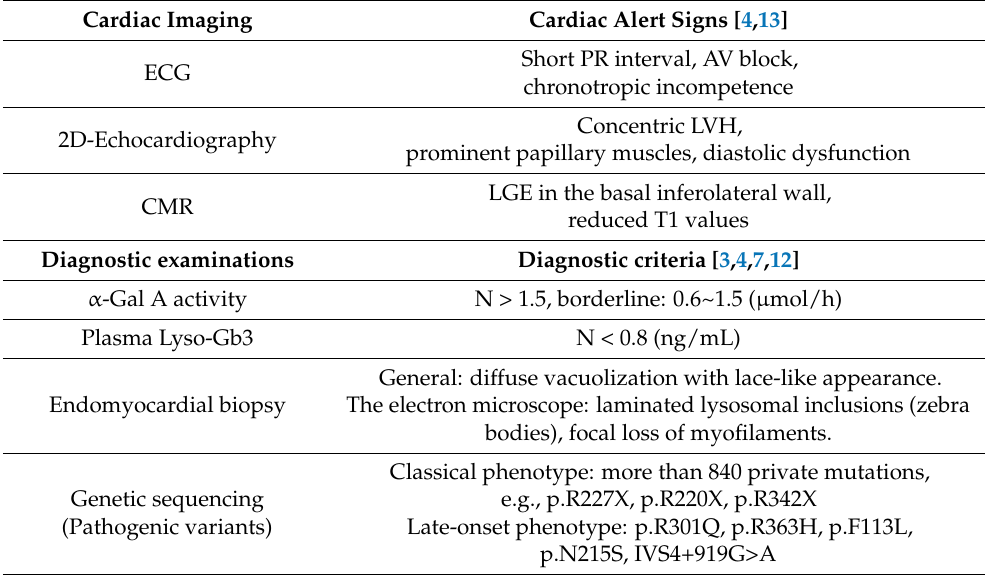
Figure 2. Brief concepts of the pathophysiology of FD [14,15]. α -Gal A: α -galactosidase A, Gb3: globotriaosylceramide, lyso-Gb3: globotriaosylsphingosine, CNS: central nervous system, PNS: peripheral nervous system. Table 3. Diagnosis and management of FD.